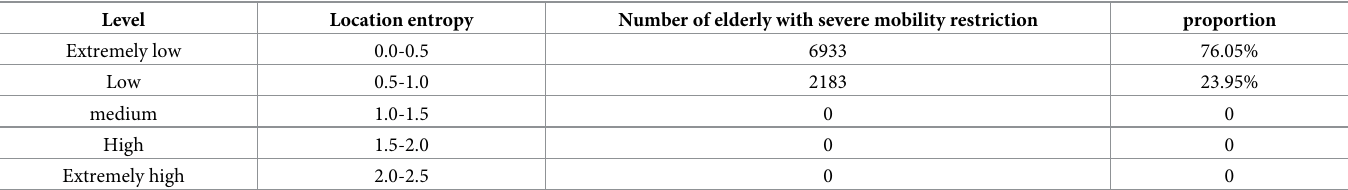
Table 8. Statistics on the number and proportion of the elderly with severe mobility restriction in the entropy sub-grade of the community home care facility